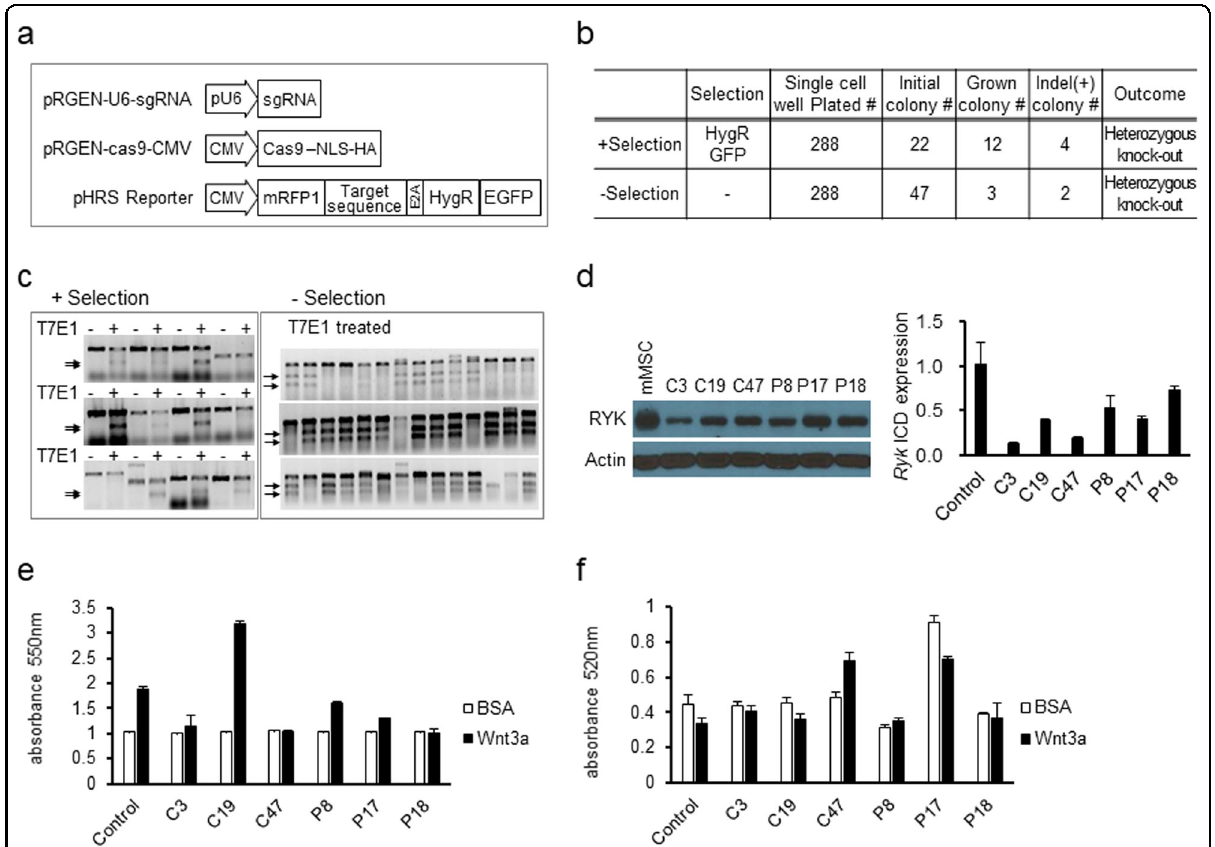
Fig. 3 Effects of CRISPR-Cas9-mediated Ryk knockout on mMSC function. a Schematic structure of the CRISPR-Cas9 system. Single guide RNA (sgRNA) speci fi c to murine Ryk , expression vectors for Cas9 and reporters for gene targeting assessed by hygromycin resistance (HygR) and enhanced green fl uorescent protein (EGFP) are shown. b Outcomes of CRISPR-Cas9-mediated mutation on Ryk in mMSCs. The summary of the numbers of surviving cells and colonies of mMSCs from each indicated experimental stage for gene-targeting of Ryk by the CRISPR-Cas9 system is shown. The number of initial colonies is the number grown during the 1st passage of culture, and the number of grown colonies is the number that survived during passaging. c Representative pro fi les for indel formation assays during CRISPR-Cas9-mediated targeting of Ryk. The indel formation by T7E1 endonuclease treatment in the colonies that survived during culture with selection (EGFP + HygR) (left panel) and indel formations from mMSC colonies that exhibited initial growth in the absence of the selection (right panel) are shown. The indels are marked with an arrow. d Expression levels of Ryk in the mMSC colonies obtained after the gene-targeting procedure. The Western blot to measure the protein levels of RYK for each single-cell derived clone indicated (left panel) and the relative expression levels of the Ryk transcript determined by real-time quantitative PCR for the intracellular domain of Ryk in each indicated single cell-derived colony obtained from gene targeting (right panel) ( n = 3) are shown. Each single colony was designated C3, C19, C14 ( − selection group), P8, P17, and P18 ( + selection group). Note an approximately 50% decrease in the RYK protein and transcript levels in the gene-targeted single cell clones, indicating heterozygous Ryk mutations. e Effects of heterozygous Ryk knockout on the differentiation of different mMSCs in response to Wnt3a ligands. Each indicated Ryk -mutant MSCs was subjected to osteogenic or